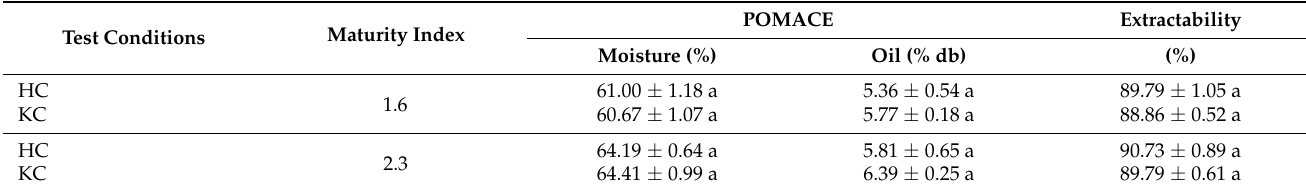
Table 4. Quantitative results and process parameters